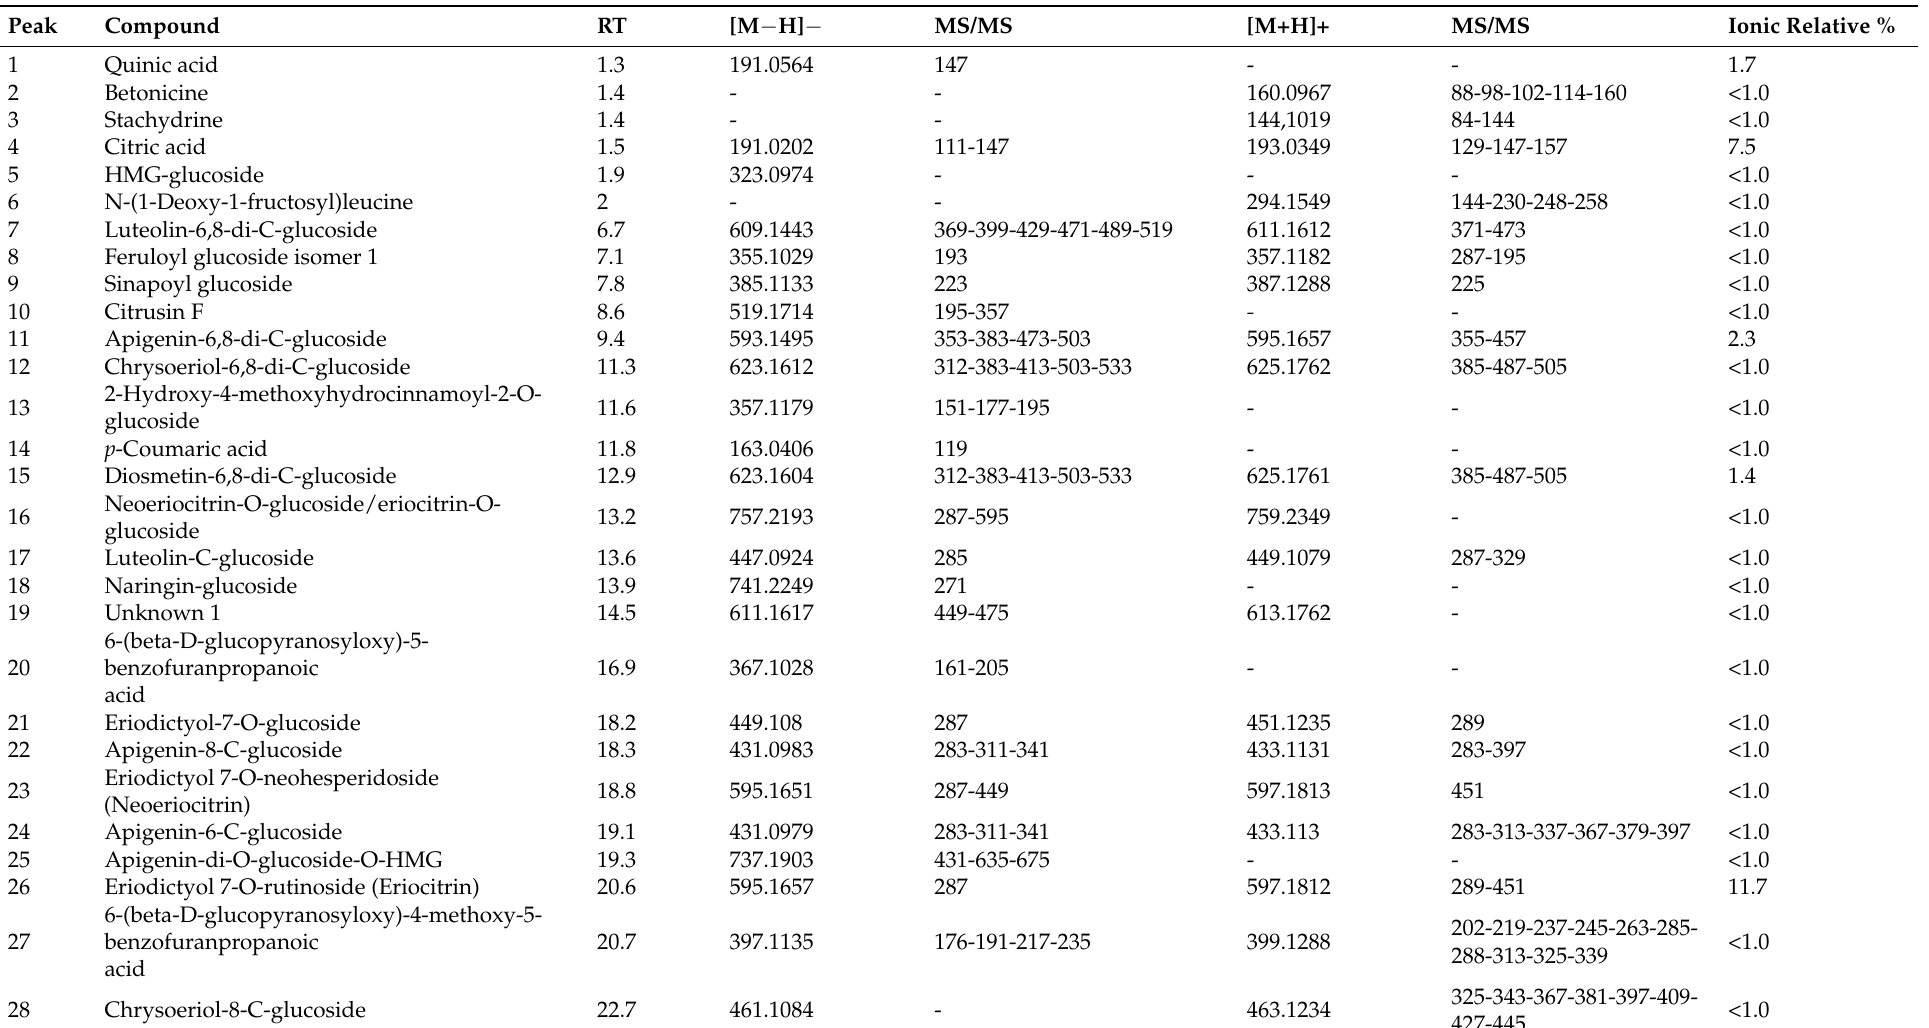
Table 2. Qualitative and semi-quantitative composition of small molecules in PBJ identified by HPLC coupled with a high-resolution